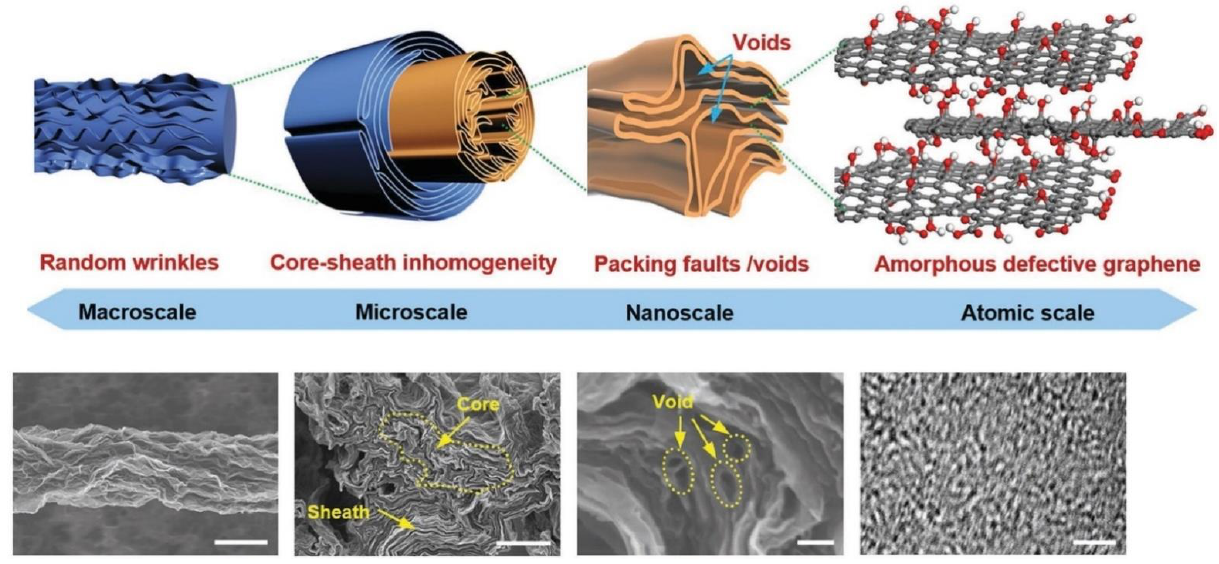
Figure 6. Structural model and corresponding electron images of multiscale defects in graphene-based fibers, including rough surface with random wrinkles, inhomogeneous core-sheath structure, default stacking and voids, and amorphous laminates of defective graphene sheets [45] (copyright permission Wiley-VCH 2016).